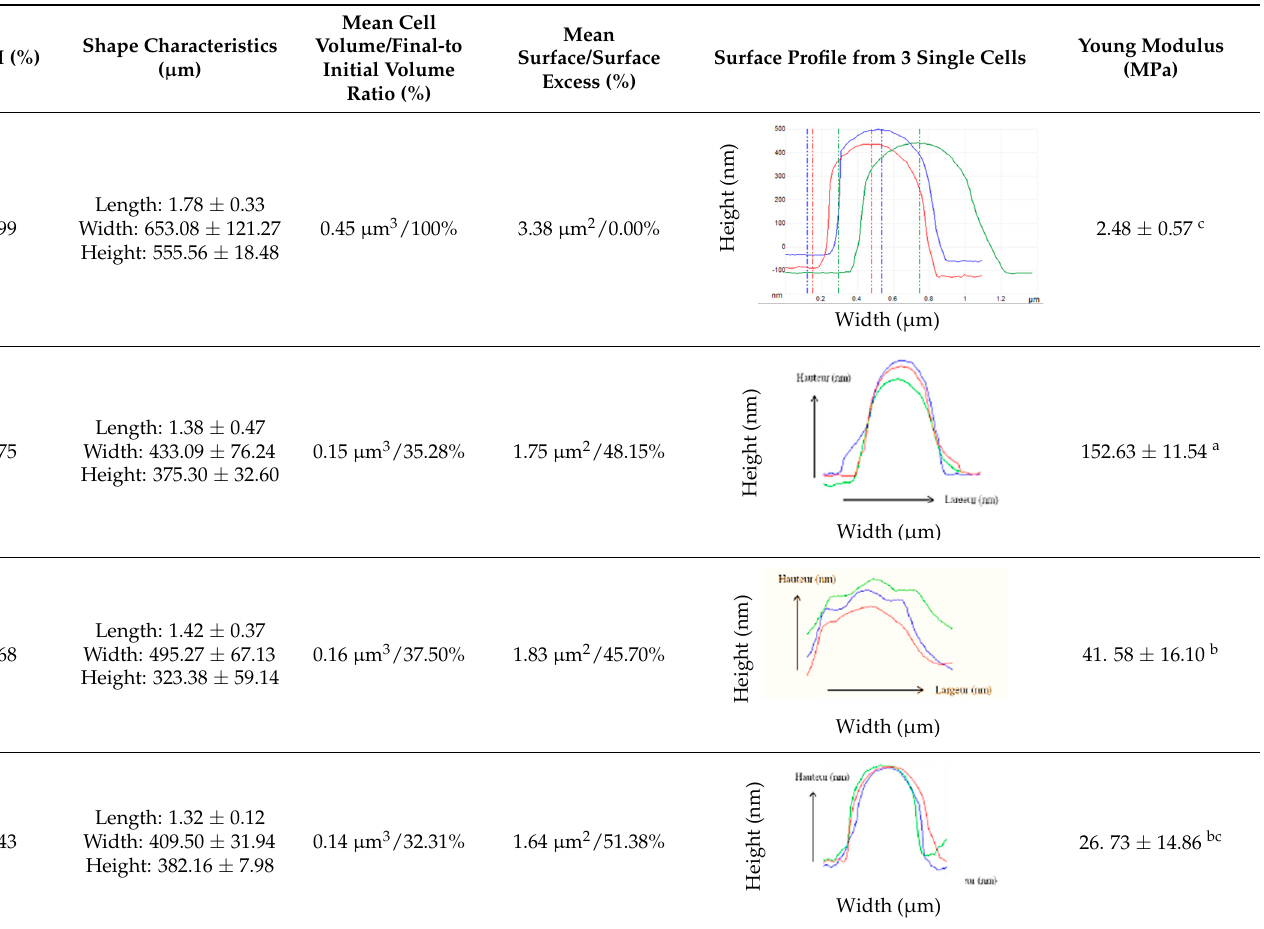
Young’s modulus values with different letters indicate significant differences ( p < 0.05) as determined by Tukey post hoc tests.